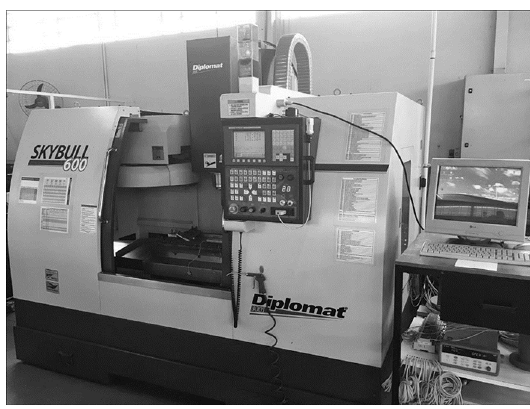
Figure 1. SKYBULL 600 CNC machine center.